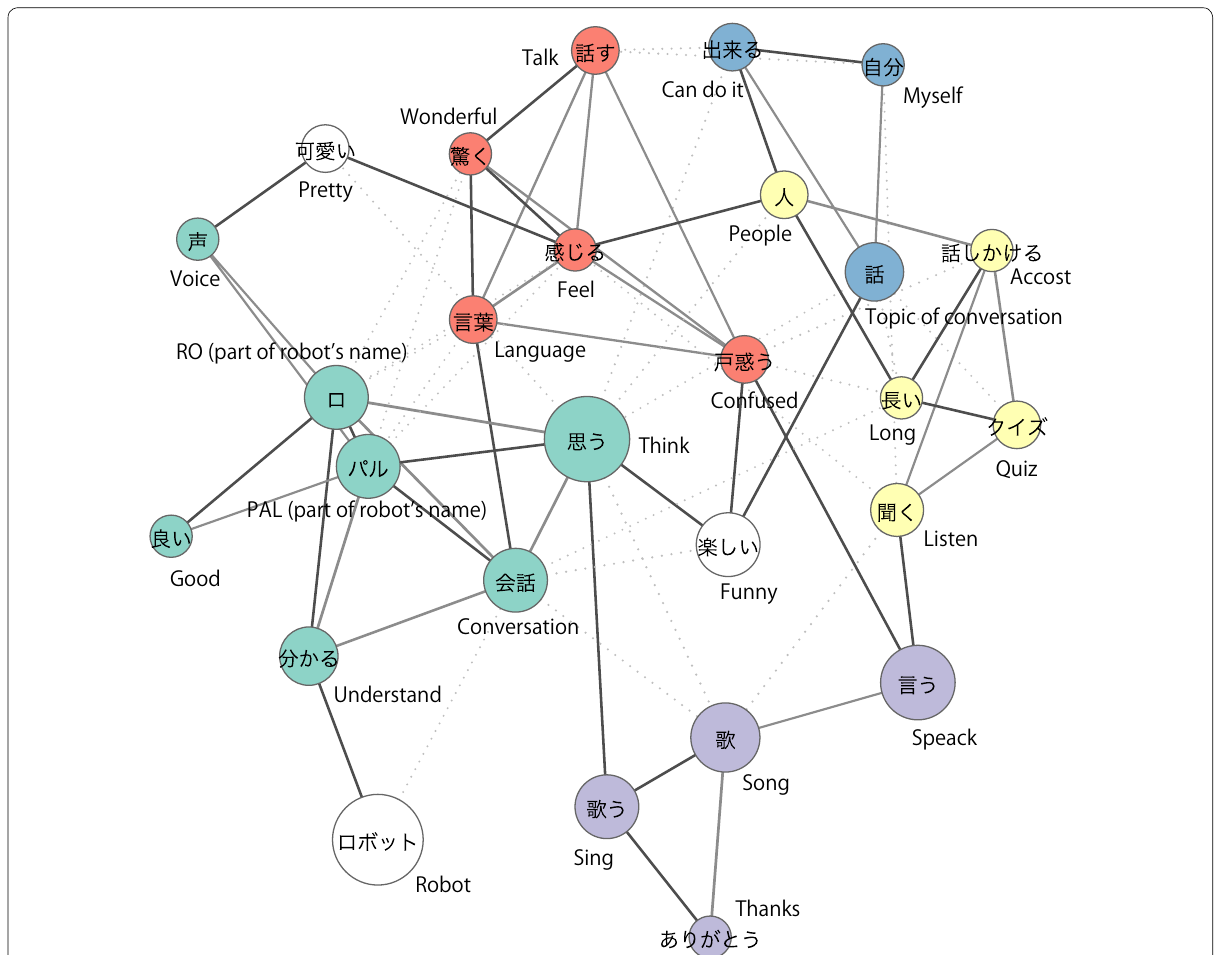
Fig. 6 Co-occurrence network graph created based on the textual data collected in the not-talkative group